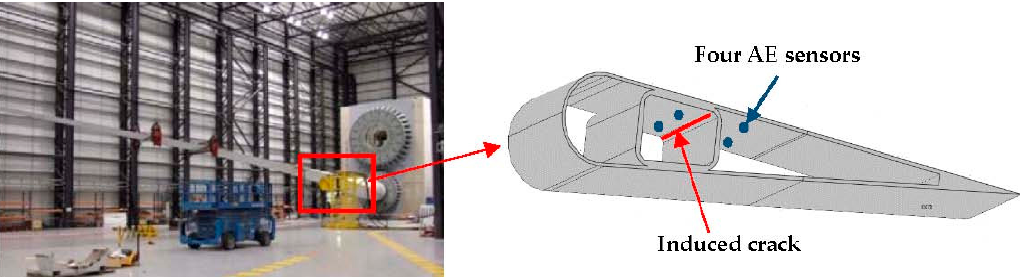
Figure 1. Wind turbine blade under test and acoustic emission (AE) sensors mounted internally on the blade.